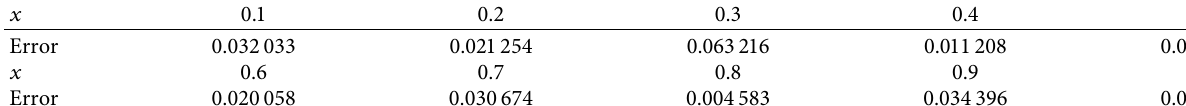
Table 1: The error of solution r ( t )( t ∈ [ 0 , 1 ]) of Example 1.